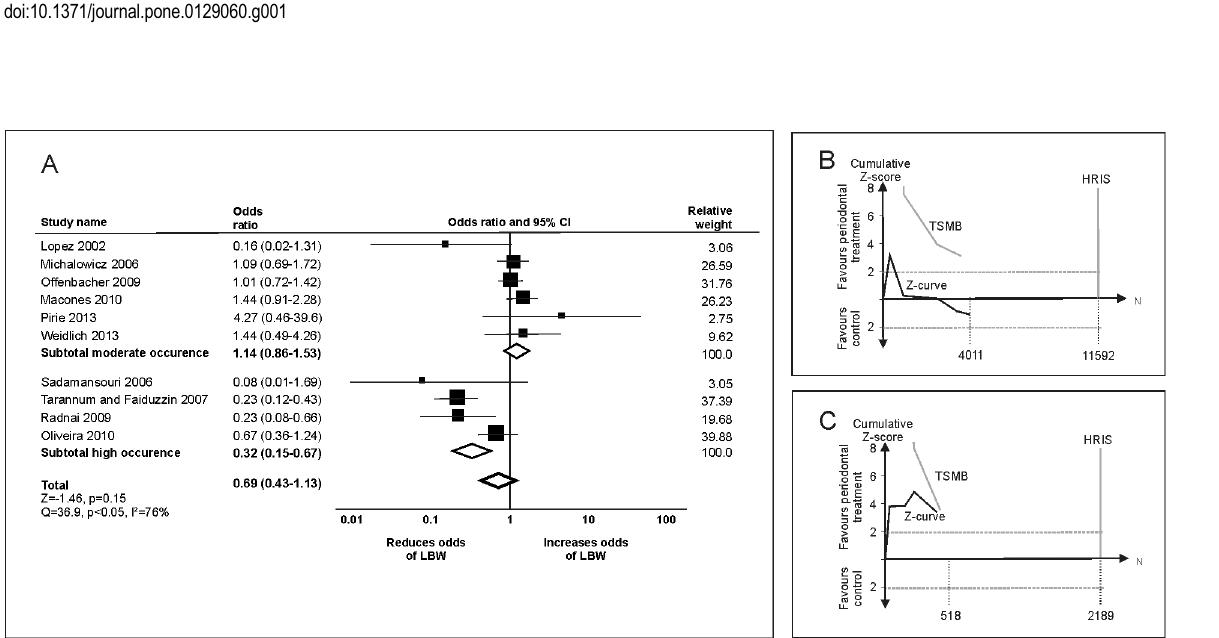
Fig 1. Periodontal treatment and preterm birth (PTB). (A) Conventional meta-analyses were performed to analyze the effect of periodontal treatment in control populations with moderate ( < 20%) and high occurrence ( (cid:1) 20%) of PTB as well as in the total population. Heterogeneity was assessed using χ 2 -test and I 2 -statistics. (B) Trial sequential analysis of trials in population with moderate occurrence of PTB. The cumulative Z-score (black), i.e., the accumulated level of significance, was plotted against the number of participants accrued so far, which was compared with the heterogeneity-adjusted required information size (HRIS). Based on HRIS, the trial sequential monitoring boundary (TSMB) for benefit was plotted (grey oblique). The Z-curve nearly crosses the futility boundary, and HRIS is not reached. (C) Trial sequential analysis of trials in population with high occurrence of PTB. The Z-curve does not reach the HRIS, and does not cross the TSMB.